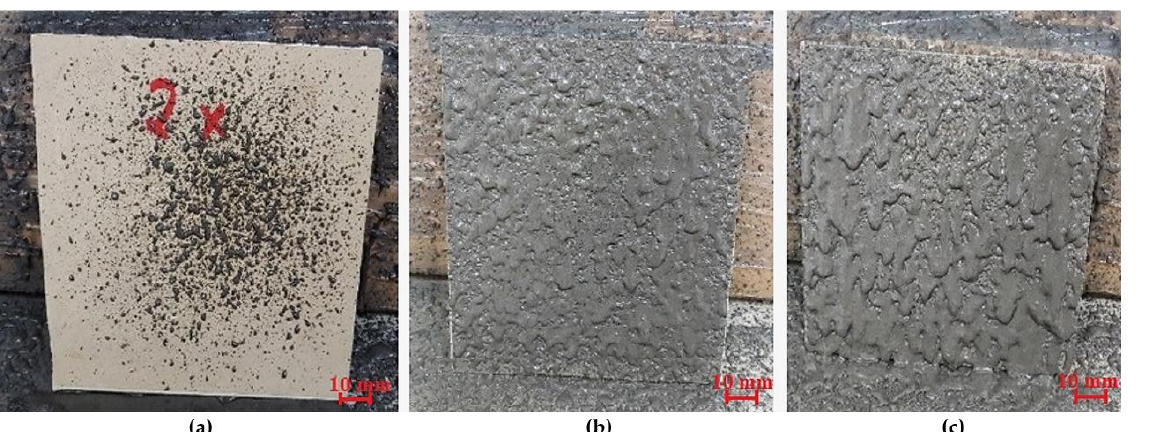
Table 6. Working pressure range of the 6 × 10 − 3 m spray nozzle for geopolymer materials. Mix 1